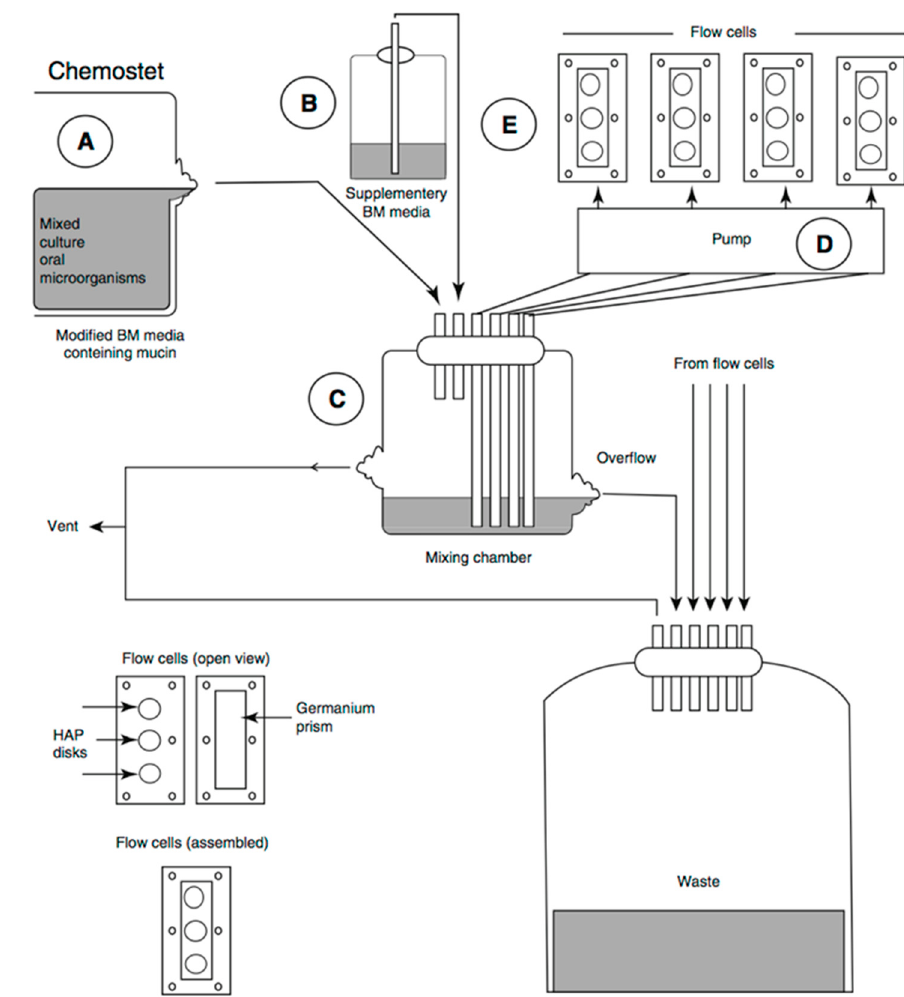
Figure 5. Configuration of the flow cell biofilm model (adapted from Herles et al., 1994 [28], with permission from © 1994 International & American Associations for Dental Research. License number: 4131180504654).